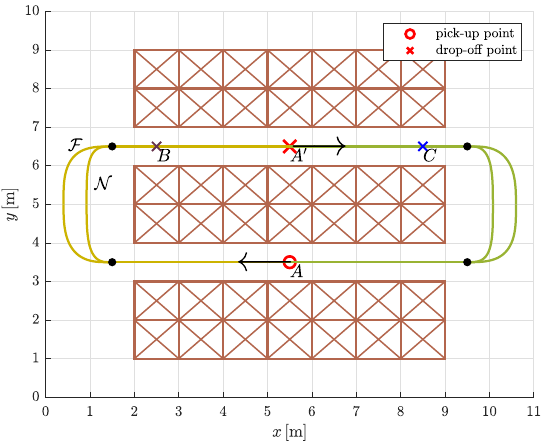
Figure 13. The drawn paths F and N are the result of an optimization that minimizes travel time. The filled dots mark the points where the straight segments meet the Bézier